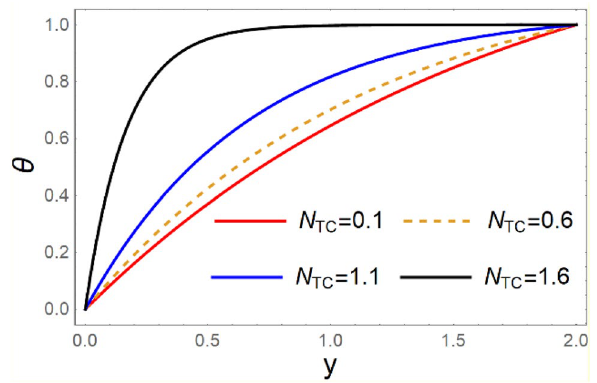
Figure 13. θ variations for N TC .